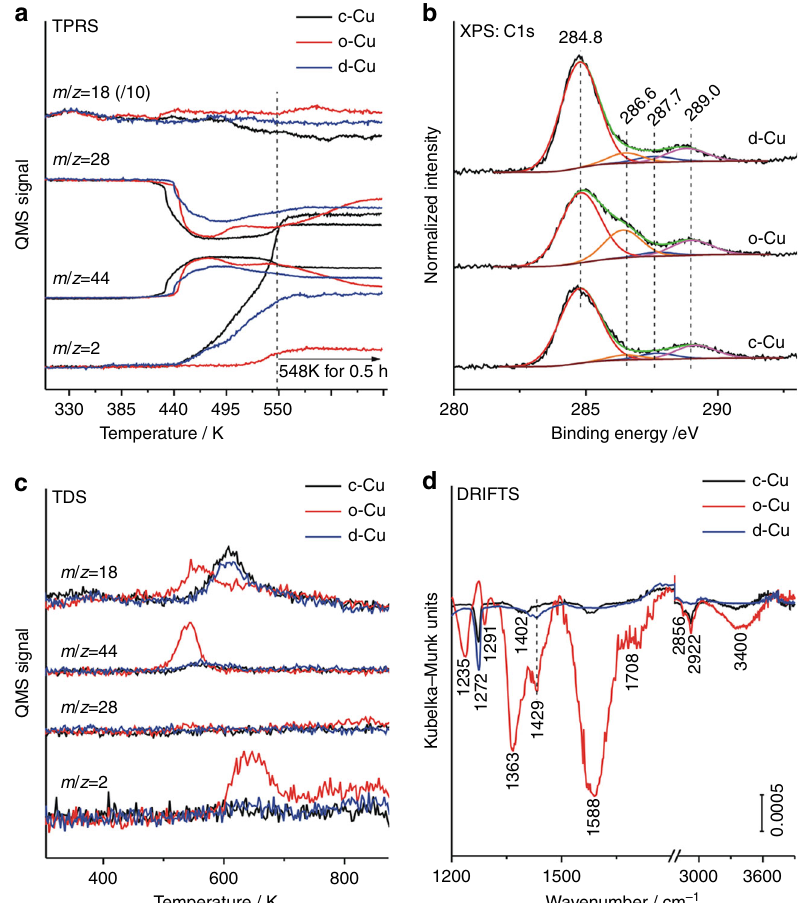
Fig. 3 Reaction mechanism. a Temperature-programmed reaction spectra of WGS reaction over Cu cubes (c-Cu), octahedra (o-Cu), and rhombic dodecahedra (d-Cu). b C 1 s XPS spectra of Cu cubes (c-Cu), octahedra (o-Cu), and rhombic dodecahedra (d-Cu) after WGS reaction at 548 K measured without exposure to air. c Thermal desorption spectra of Cu cubes (c-Cu), octahedra (o-Cu), and rhombic dodecahedra (d-Cu) after WGS reaction at 548 K. d In situ diffuse re fl ectance infrared spectra of Cu cubes (c-Cu), octahedra (o-Cu), and rhombic dodecahedra (d-Cu) after WGS reaction at 548K followed by heating in Ar to 723